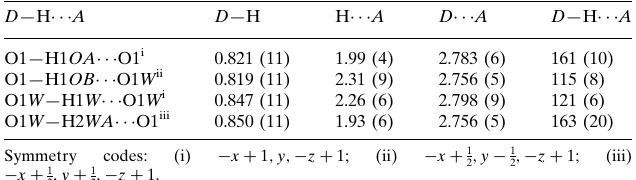
Hydrogen-bond geometry (A˚ , (cid:3)